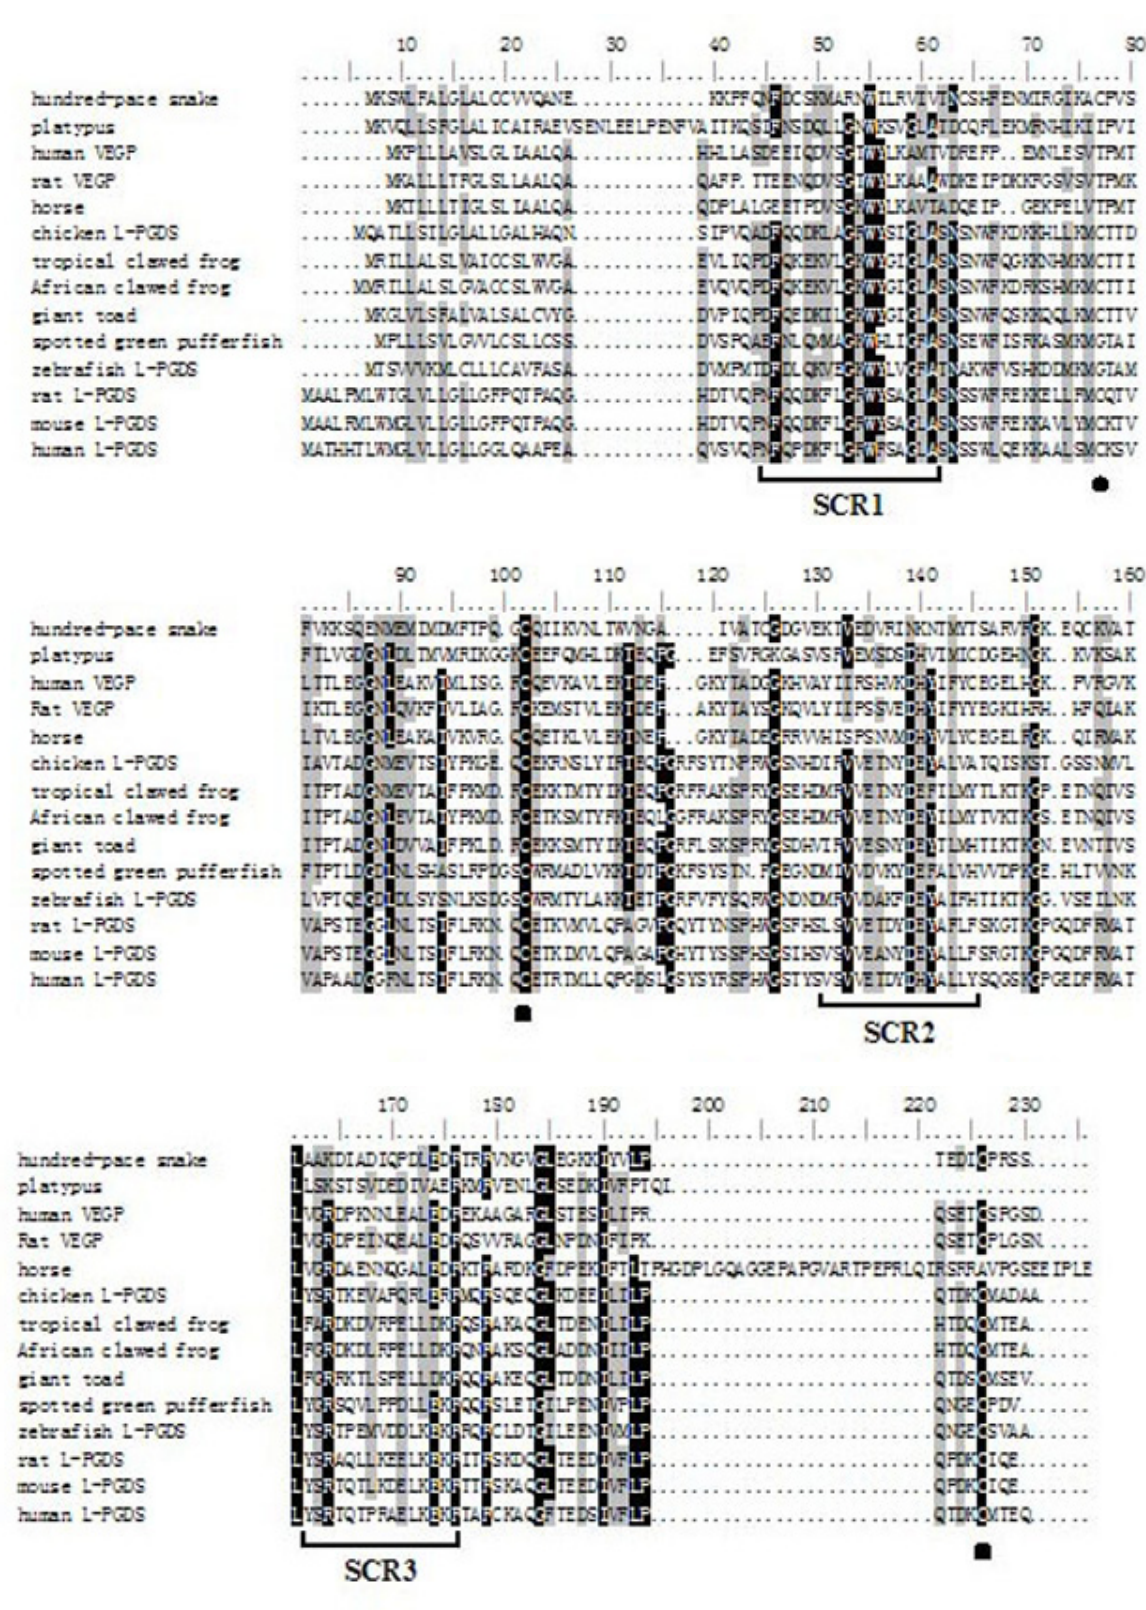
Figure 1. Multiple alignment of predicted amino acid sequences of hundred-pace snake lipocalin with the homologous sequences from some animals using ClustalW program and displayed by BioEdit Sequence Alignment Editor. Shading threshold was > 70%, similar residues are marked as gray shadow, identical residues as black shadow and alignment gaps as “–”. The Cys residues essential for L-PGDS activity in mammals are shown by a closed circle, and the two Cys residues required for the disulfide-bond formation are indicated by closed squares below the alignment. Three SCRs are indicated below the